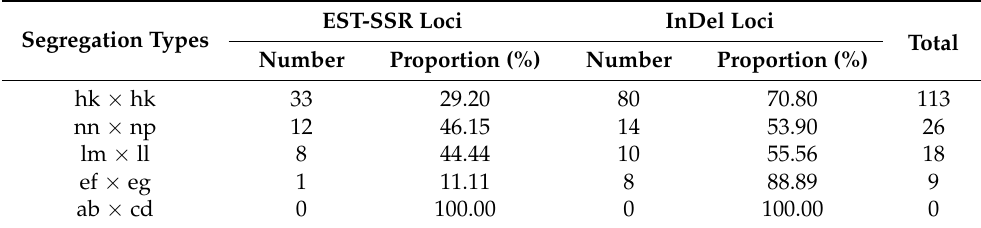
Table 2. Loci number of the different segregation